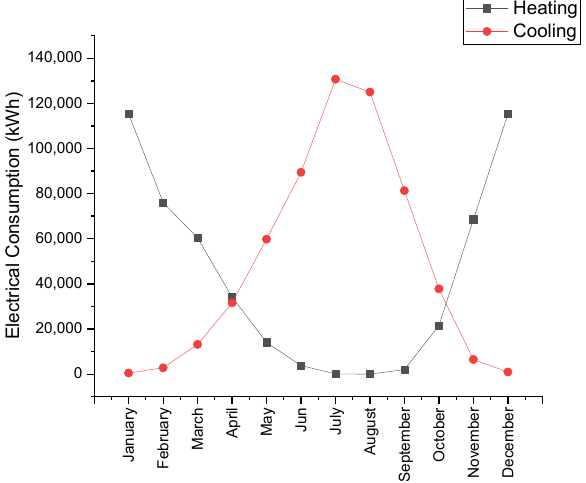
Figure 15. Power consumption of the GHP in both modes of operation.